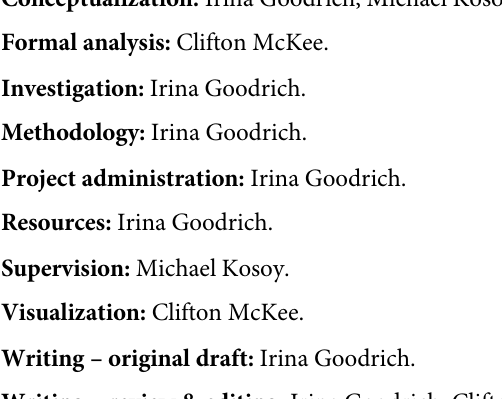
S6 Table. GenBank accession numbers and host information on reference Trypanosoma species used for phylogenetic